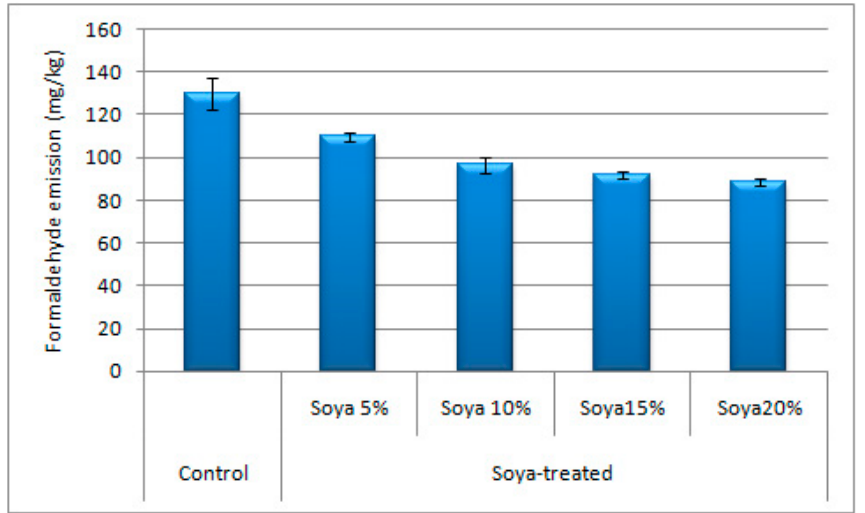
Figure 4. Formaldehyde emission (mg/kg) in three-layer plywood panels produced with urea- Figure formaldehyde resin and 5%, 10%, 15%, and 20% soy flour substitution of UF resin.